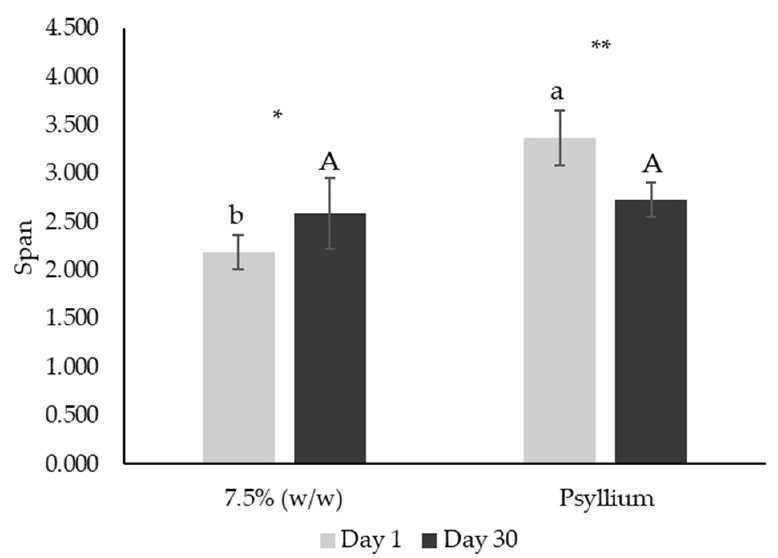
Figure 13. Span parameter from droplet size distribution of emulsions with 7.5% ( w / w ) of miso paste, one of them with 0.1% ( w / w ) of psyllium husk, measured 1 (a) and 30 (b) days after emulsion preparation. Different letters or two asterisks indicate significantly different results ( p < 0.05) according to t -test. One asterisk indicates that samples did not present significantly different results ( p > 0.05) according to t -test.